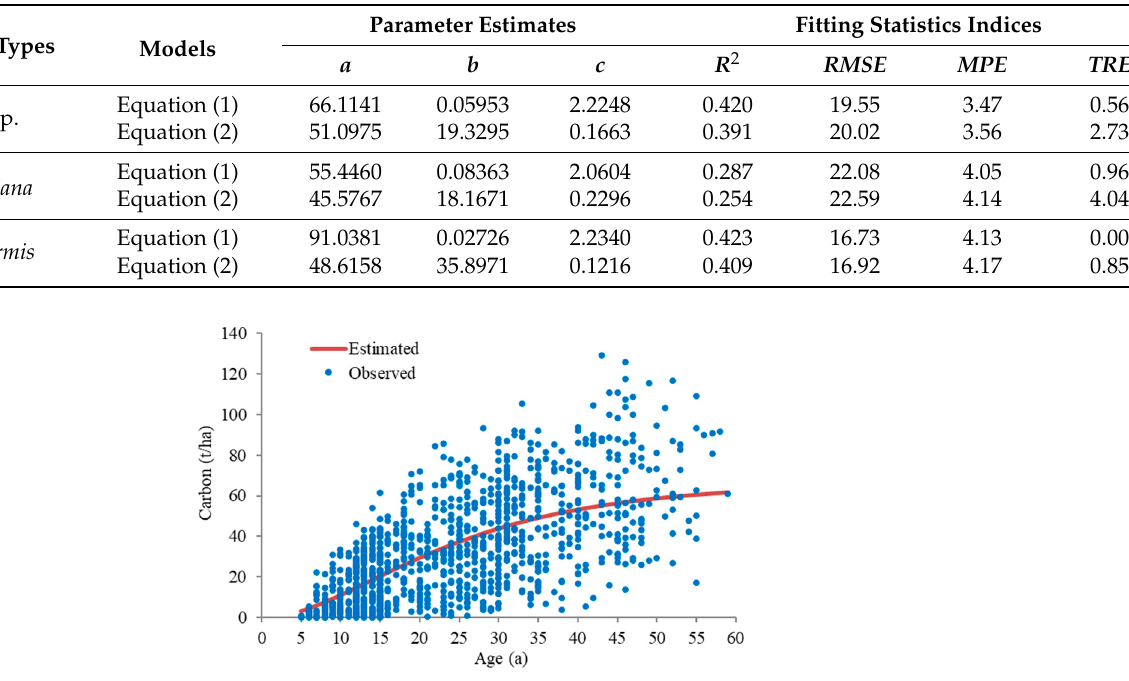
Table 2. Parameter estimates and fitting statistics indices of base model.